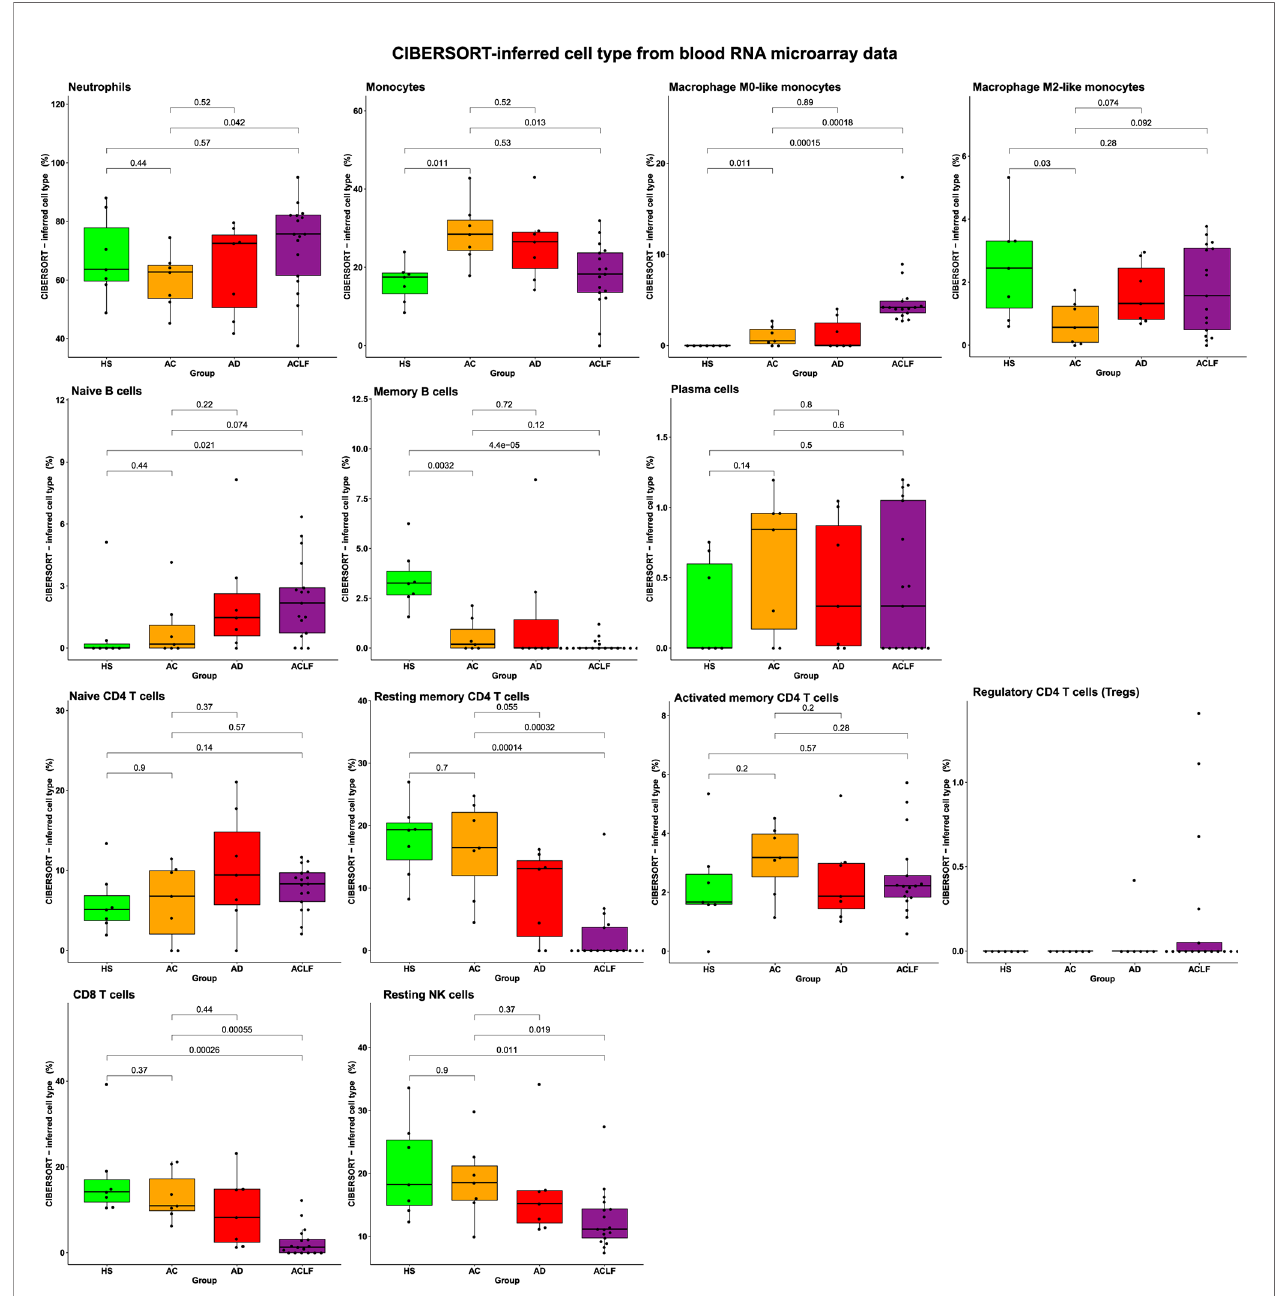
FIGURE 3 | The CIBERSORT method identi fi es alterations in blood immune-cell subset composition in ACLF. There were seven healthy subjects (HS), seven patients with advanced cirrhosis (AC), seven patients with acutely decompensated cirrhosis (AD), and 17 patients with ACLF. P values were obtained using one-way ANOVA and unpaired t